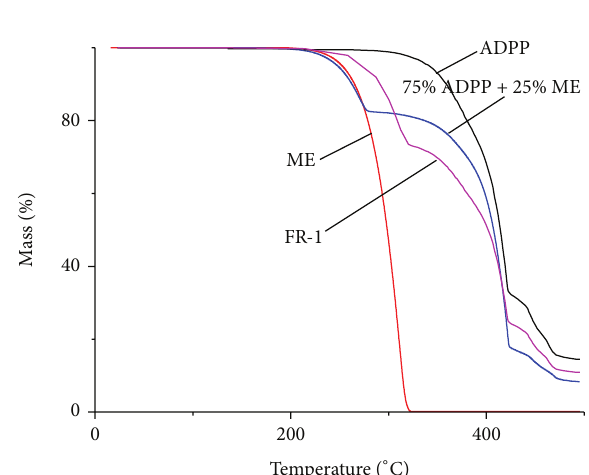
Figure 4: TG of ADPP, ME, and the combination of ADPP/ME. FR- 1: additive curve of 75% ADPP and 25%